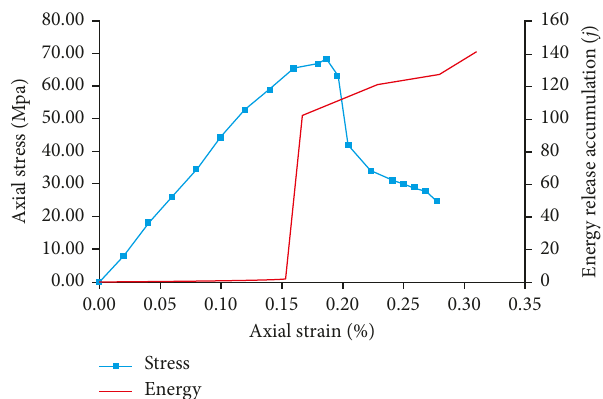
Figure 14: The simulated stress-strain curve and the released strain energy.